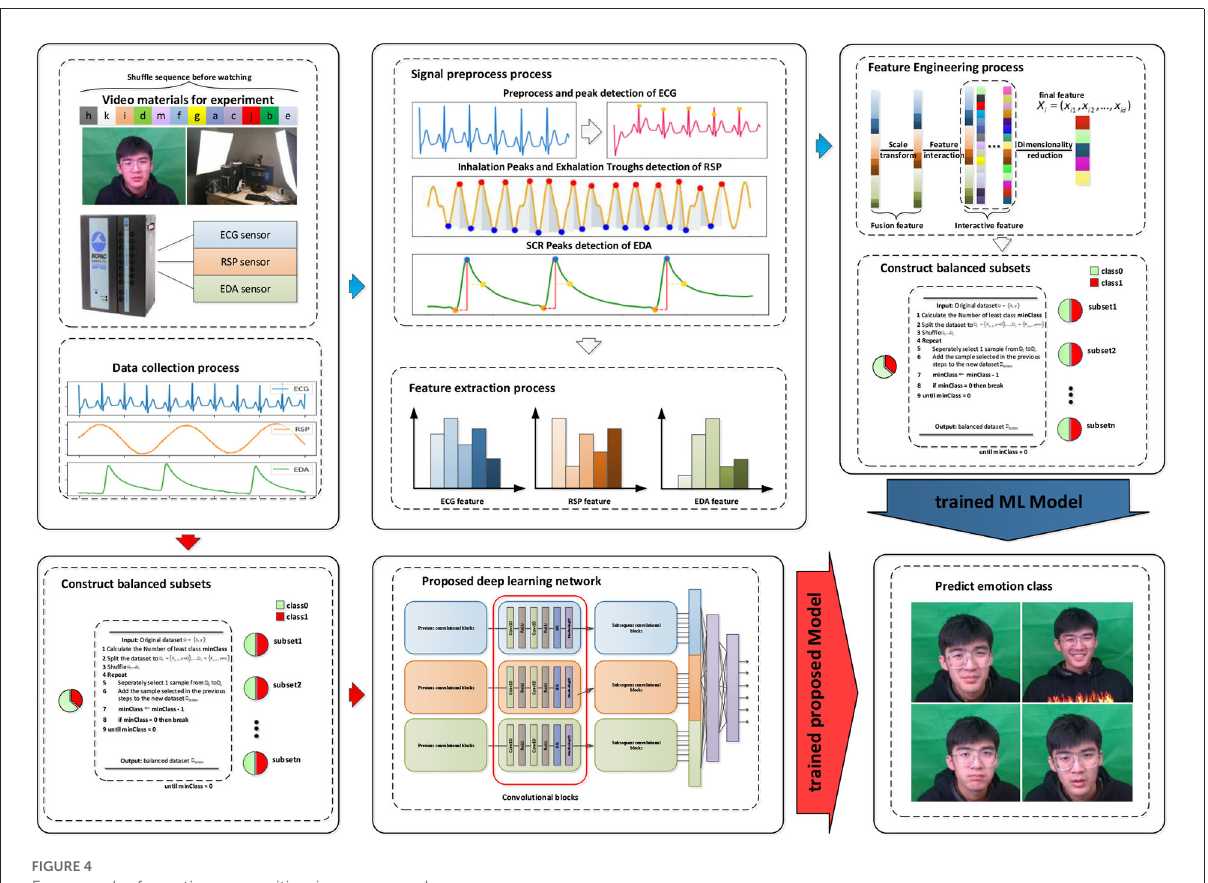
FIGURE4 Framework of emotion recognition in our